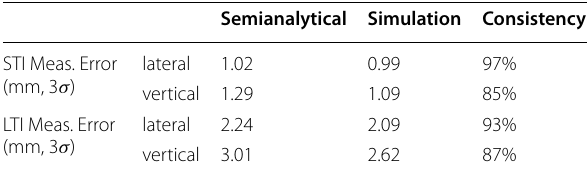
Table 2 Comparison of the track irregularity measurement accuracy analysis results from the semianalytical and simulation